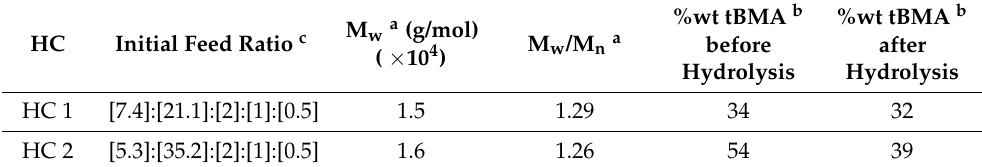
Table 1. Molecular characteristics of the synthesized